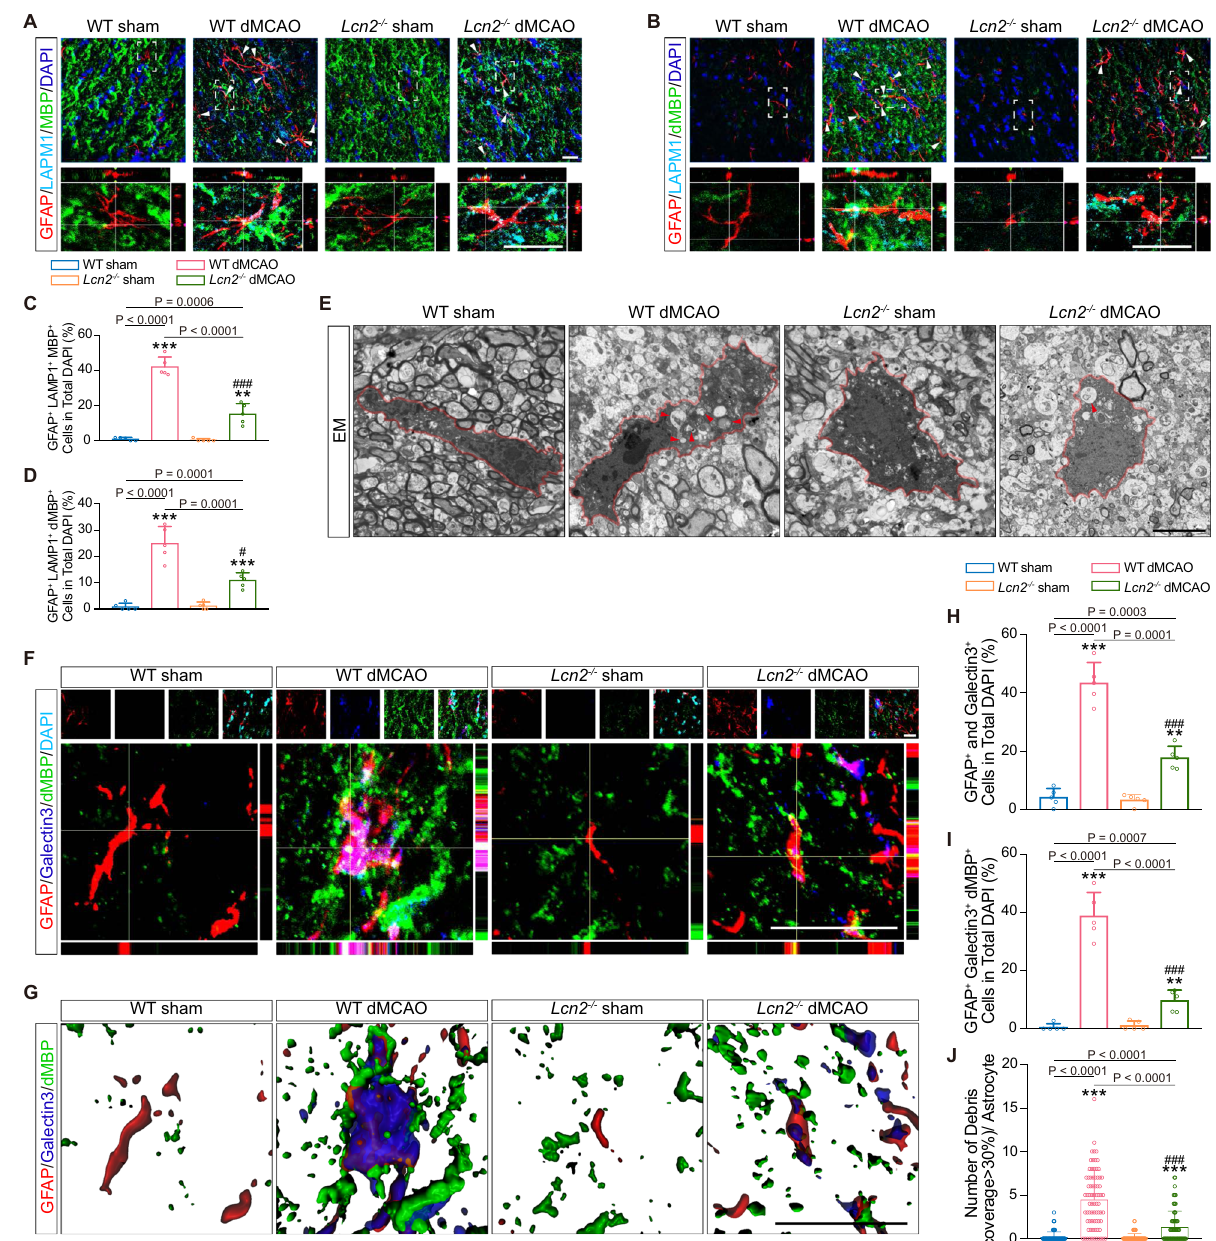
Fig. 4 Ablation of Lcn2 abrogates the transformation of reactive astrocytes into myelin-laden phagocytes after dMCAO. A Representative images showing the changes of the reactive astrocytes (GFAP, red) containing MBP-positive (green) myelin inclusions (white arrows) in lysosome (LAMP1, cyan) among demyelination lesion. Scale bar, 20 μ m. B Immunostaining images of triple-labeled astrocytes (GFAP + , red) containing dMBP-positive (green) myelin fragments in LAMP1 + lysosome (cyan). White arrows indicated phagocytic astrocytes. Scale bar, 20 μ m. C , D Quanti fi cation of triple-positive astrocytes obtained from immuno fl uorescence staining ( n = 5 mice; adjusted ** P < 0.0017, *** P < 0.0002 vs. WT sham; # P < 0.0083, ### P < 0.0002 vs. WT dMCAO; two-way ANOVA, repeated-measures t -test). E Representative EM images of astrocytes in the ipsilateral CC of WT and Lcn2 − / − mice. Phagocytic inclusions with myelin-like structures were shown with red arrows. Scale bar, 5 μ m. F Representative orthogonal views of Z-stack images obtained from two genotypes. GFAP + (red) and Galectin3 + (blue) astrocytes engulfed dMBP + (green) myelin debris after dMCAO. Scale bar, 20 μ m. G Representative 3D images acquired from confocal images. Scale bar, 20 μ m. H , I Quanti fi cations showing the changes of co-positive (GFAP + and Galectin3 + ) phagocytic astrocytes and phagocytic astrocytes containing myelin debris (GFAP + , Galectin3 + and dMBP + ) ( n = 5 mice; mean ± S.D.; adjusted ** P < 0.0017, *** P < 0.0002 vs. WT sham; ### P < 0.0002 vs. WT dMCAO; two-way ANOVA, repeated-measures t -test). J Quanti fi cation of the number of myelin debris contacted with or internalized by a single astrocyte according to 3D reconstruction images ( n = 75 cells from fi ve animals in each group; mean ± S.D.; adjusted *** P < 0.0002 vs. WT sham; ### P < 0.0002 vs. WT dMCAO; two-way ANOVA, repeated-measures t -test). Source data are provided as a Source Data fi le.